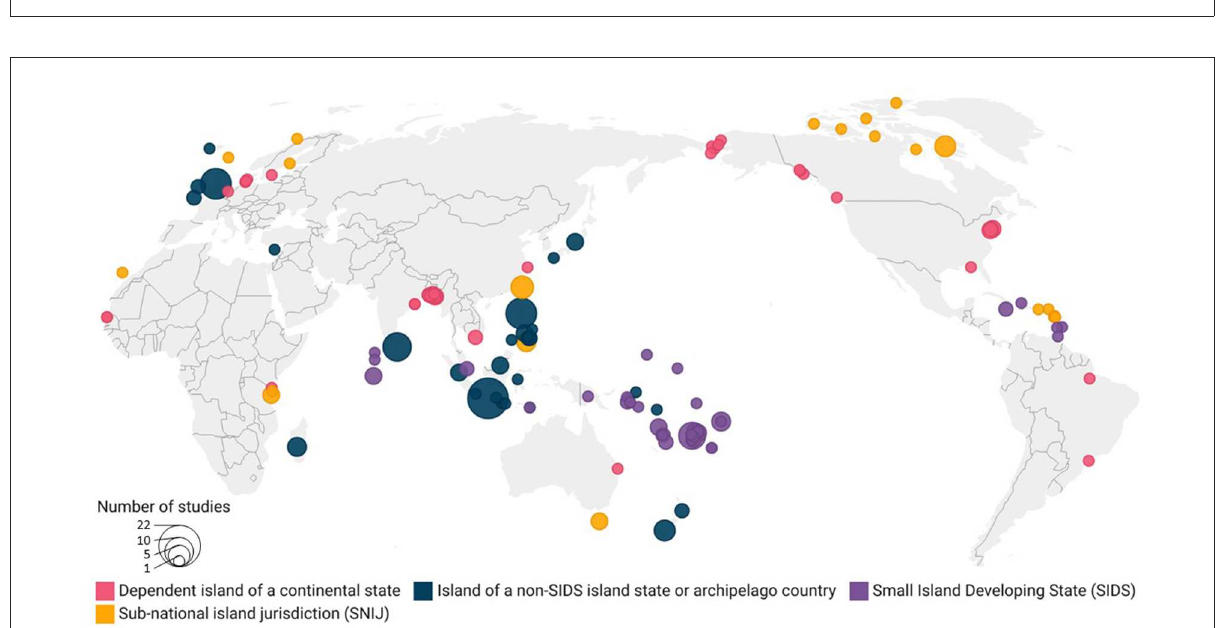
FIGURE4 The global distribution of island case studies in the GAMI database. Colors refer to different island types and the size of circles to the number of studies on the same island.